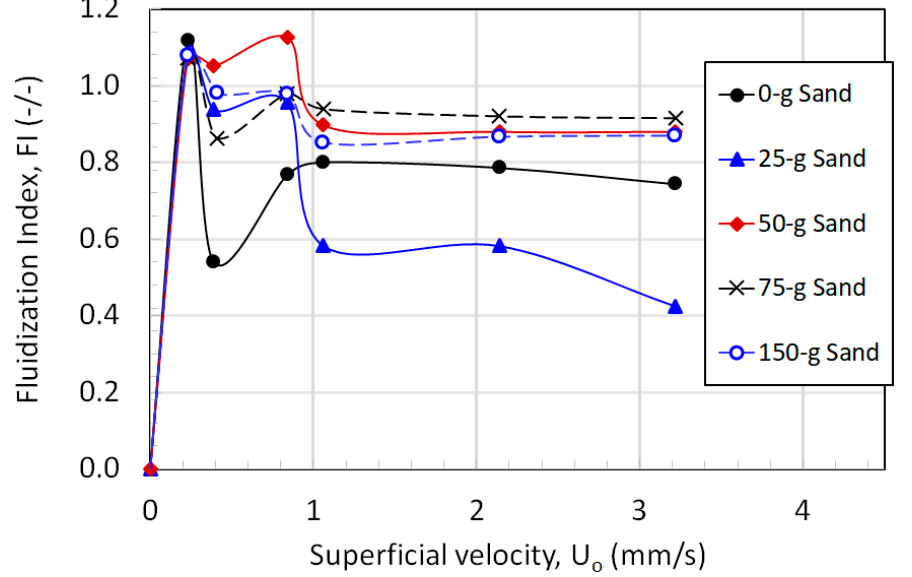
Figure 12. Effect of the addition of external particles on the fluidization hydrodynamics of the monocomponent bed and mixed bed of activated carbon and sand.